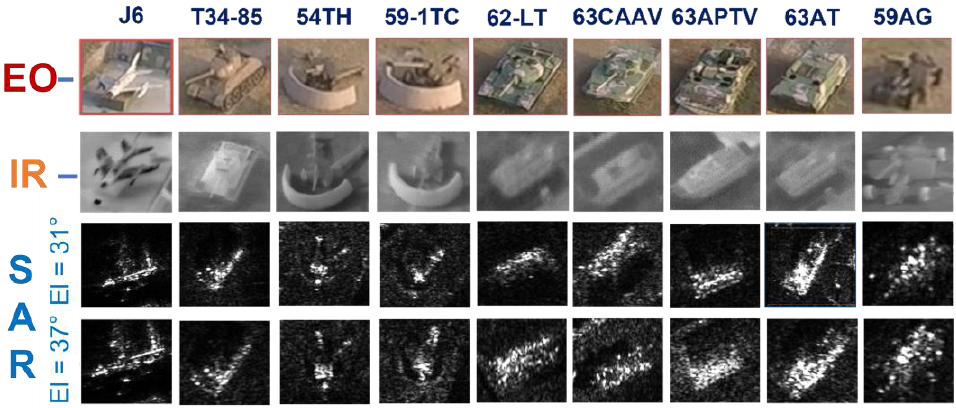
Figure 6. SAR images of military vehicles collected by the NUAA